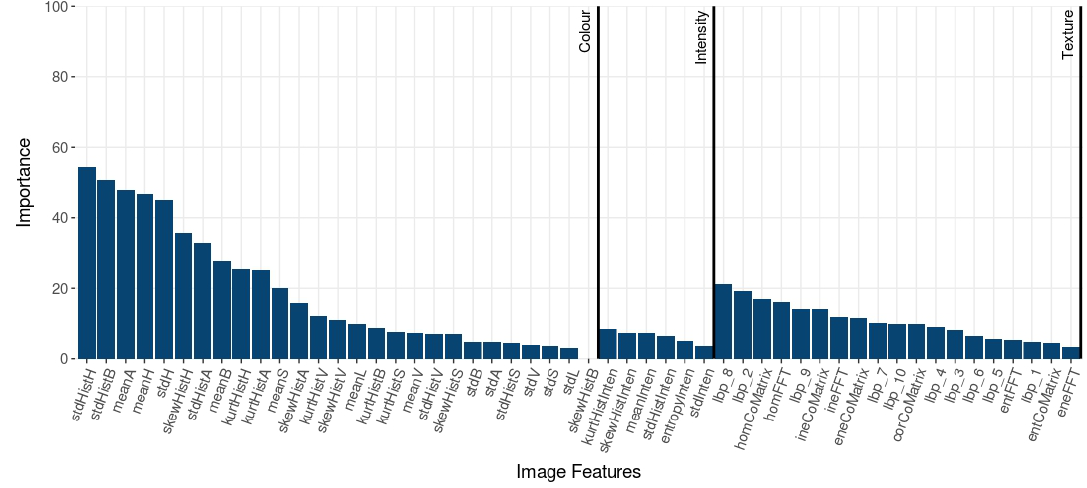
Figure 5. RF importance of image